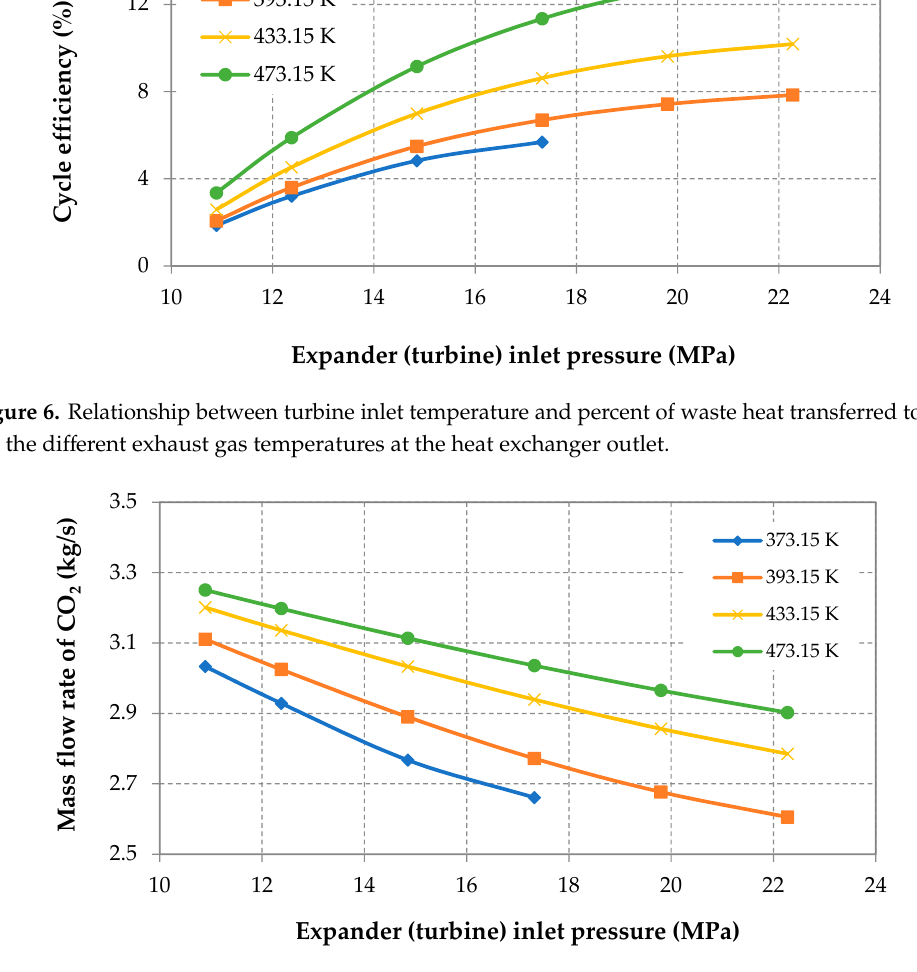
Figure 7. Relationship between turbine inlet pressure and mass flow rate of CO 2 for the different exhaust gas temperatures at the heat exchanger outlet.